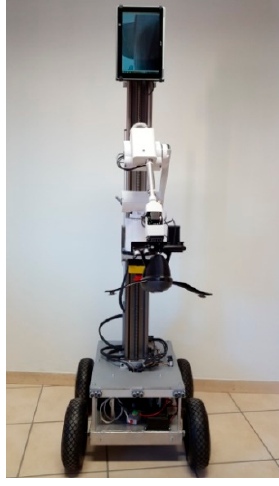
Figure 1. Developed assistive telepresence robot.